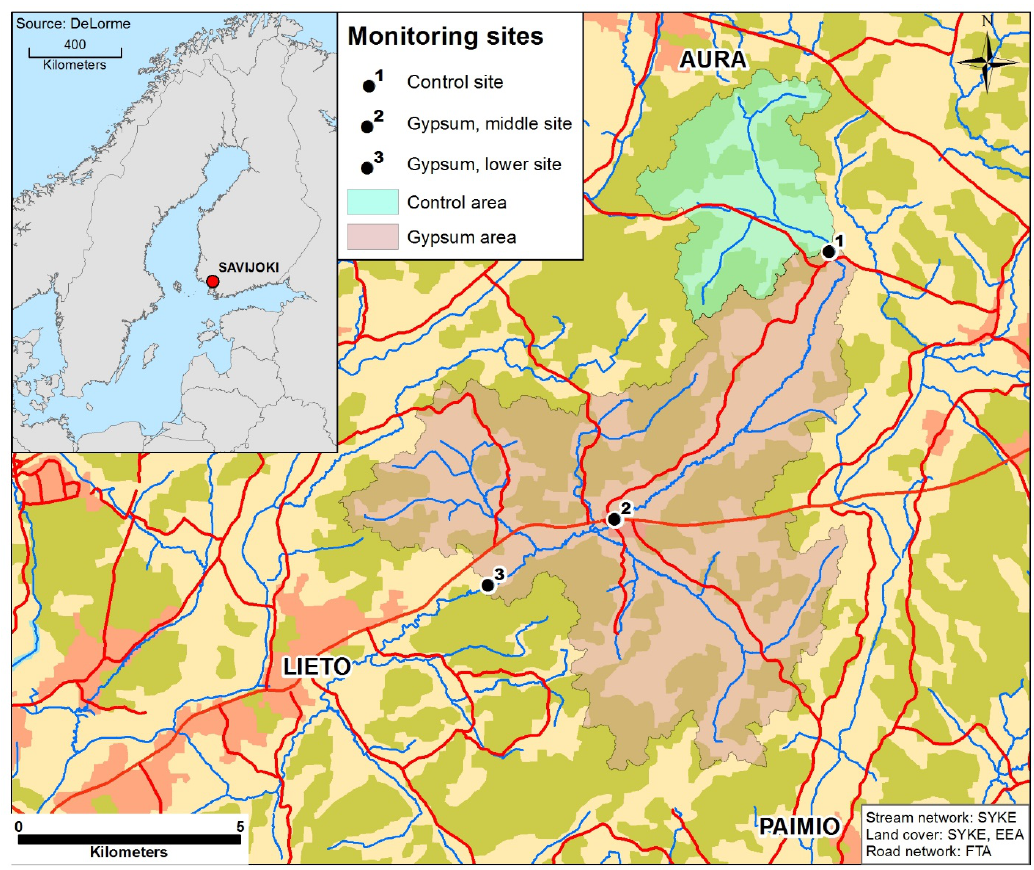
Fig. 1. The gypsum amendment area, the control area, and the three monitoring sites along the River